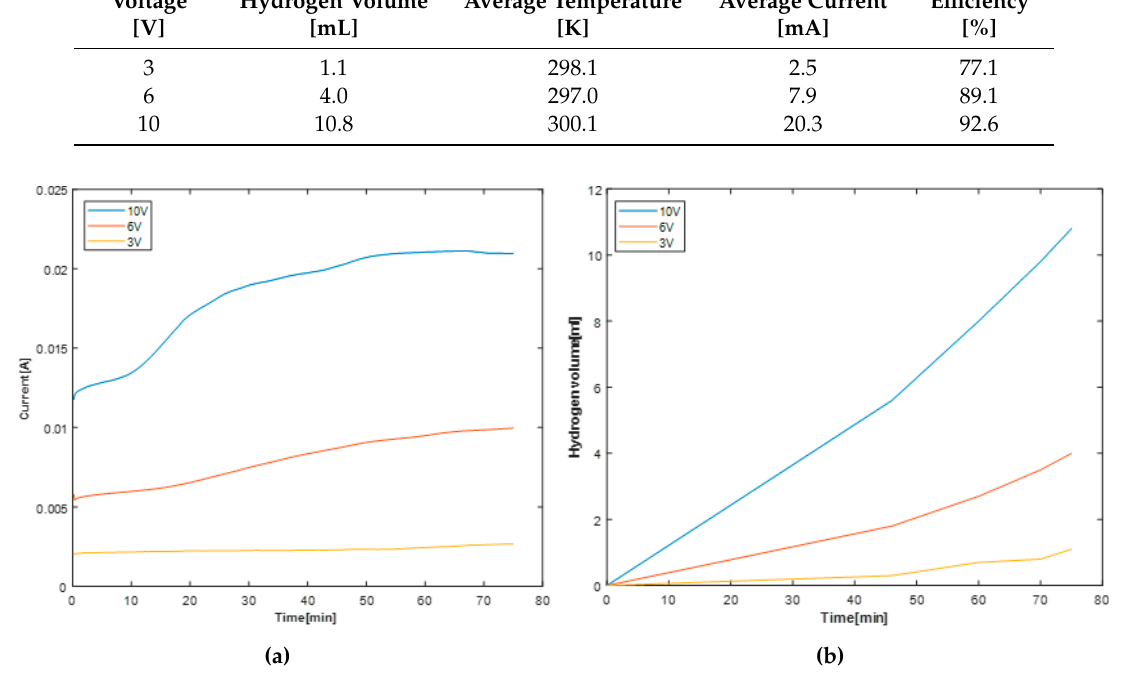
Figure 7. Experimental results according to the applied voltage ( a ) Current ( b ) Hydrogen generation. Table 4. Experimental results according to the applied voltage.